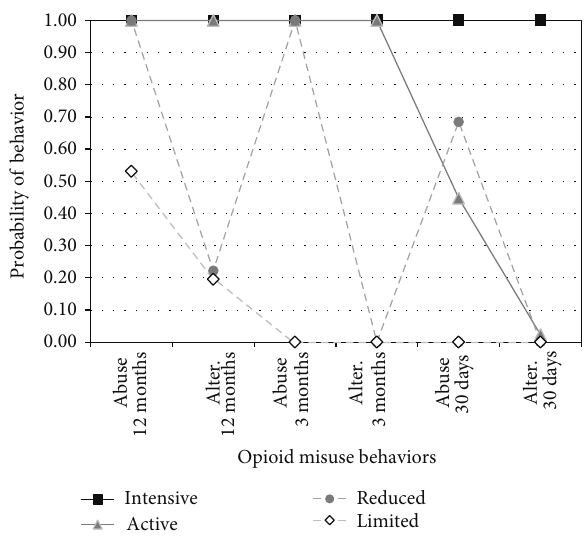
Figure 1: Probabilities of 12-month, 3-month, and 30-day opioid misuse (“abuse”) and alternate modes of administration (“alter”) for each of the four latent